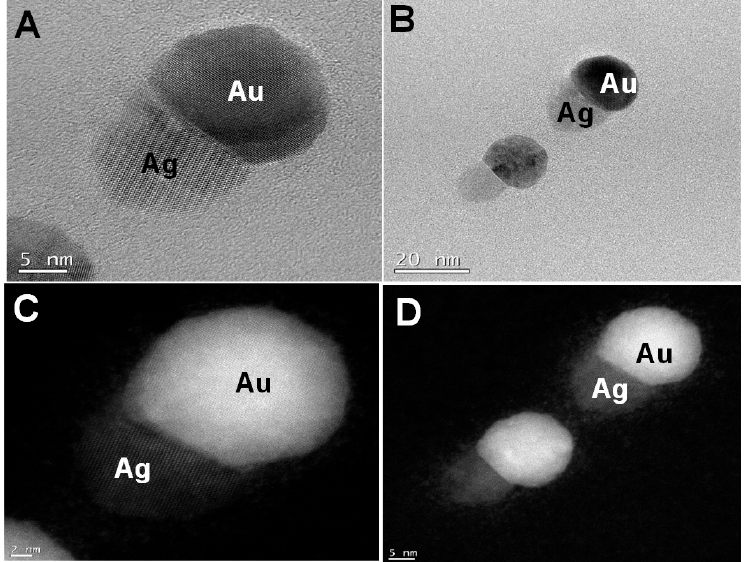
Figure 3. Bright field ( A , B ) and dark field ( C , D ) TEM images of the conjoined Au-Ag nanotwins formed by irradiation of the seed for 90 min in the seeding step and 30 min in the second step.